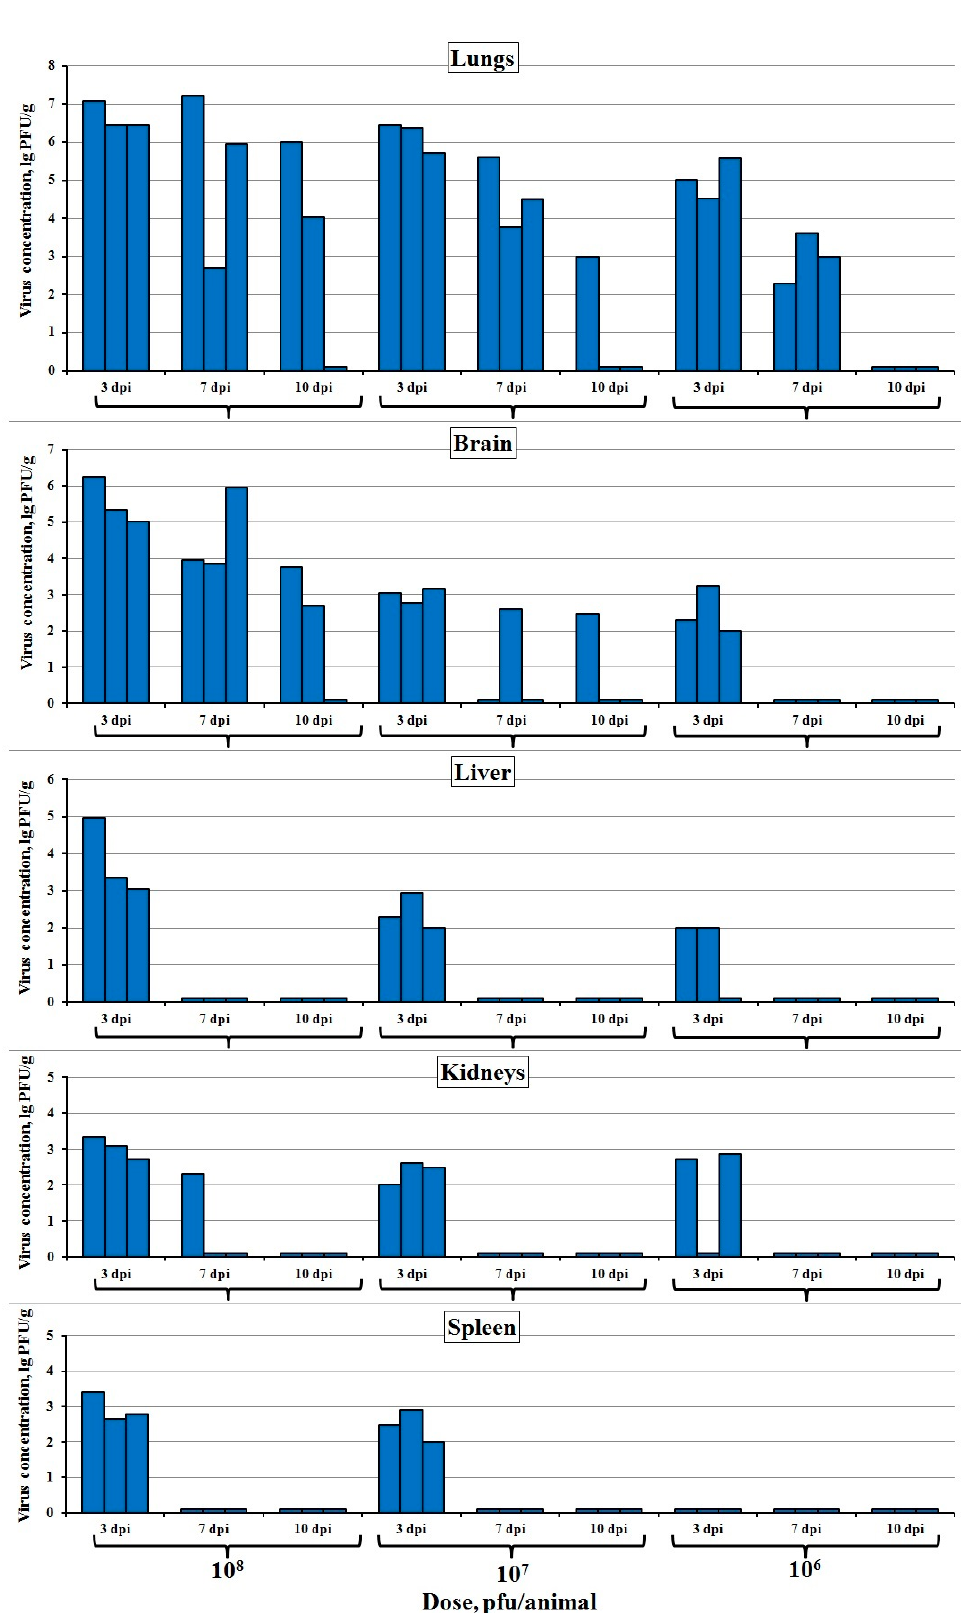
Figure 2. VACV concentration in the internal organs of mice intranasally infected with the LIVP-14 strain at doses of 10 6 , 10 7 , and 10 8 pfu. The data for individual animals on days 3, 7, and 10 post-inoculation (dpi) are presented. Organs of three mice were analyzed at each time point.